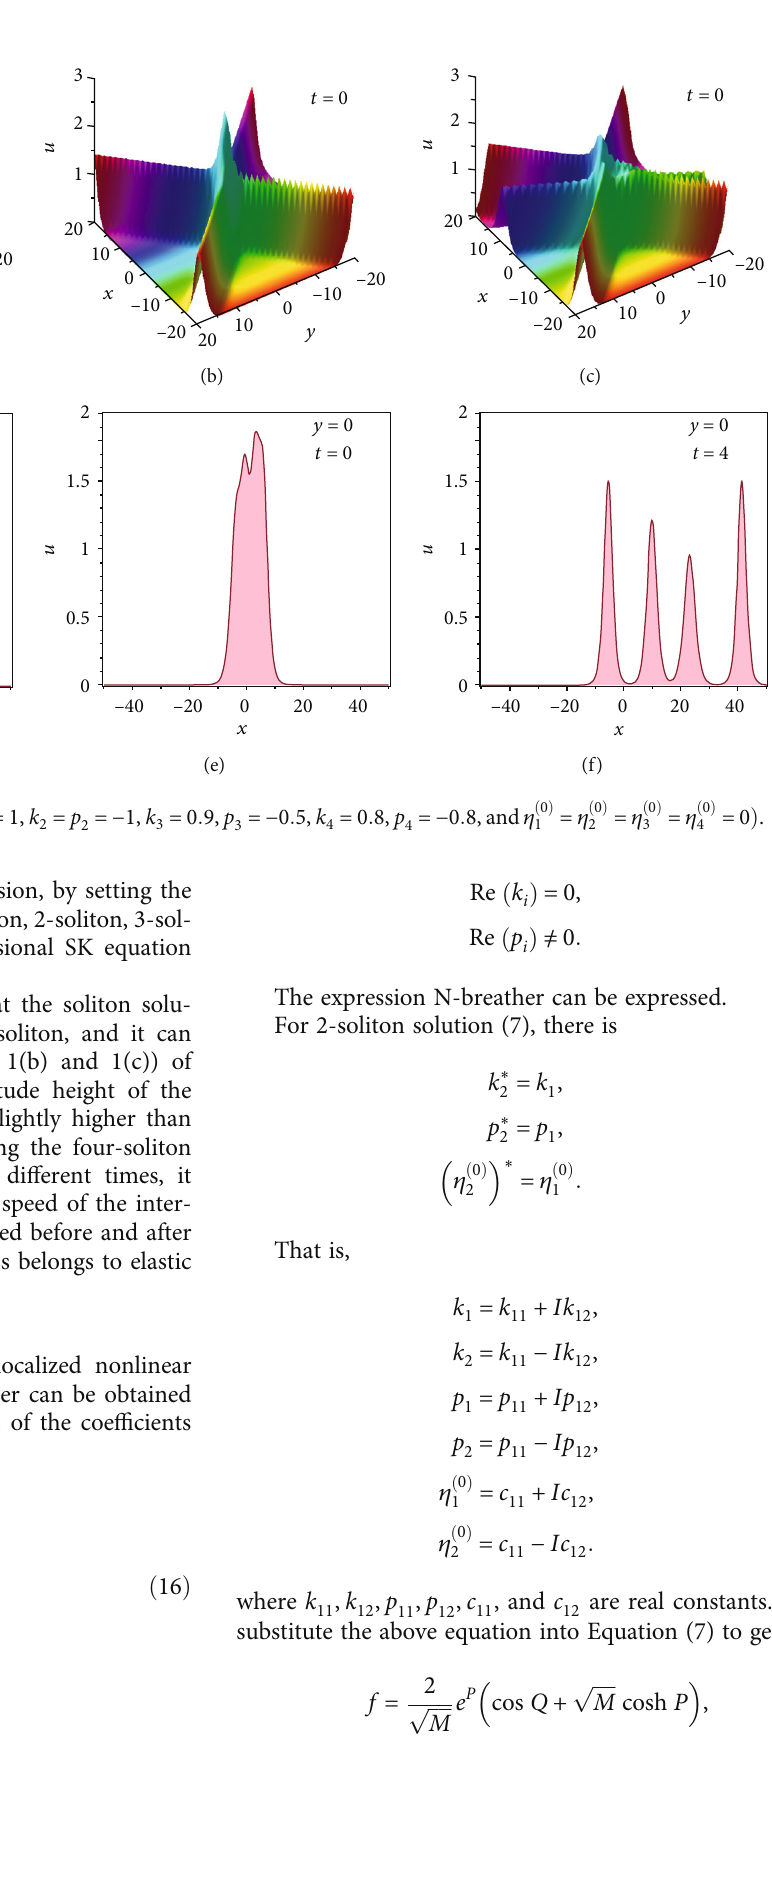
Figure 1: Soliton solutions ð k